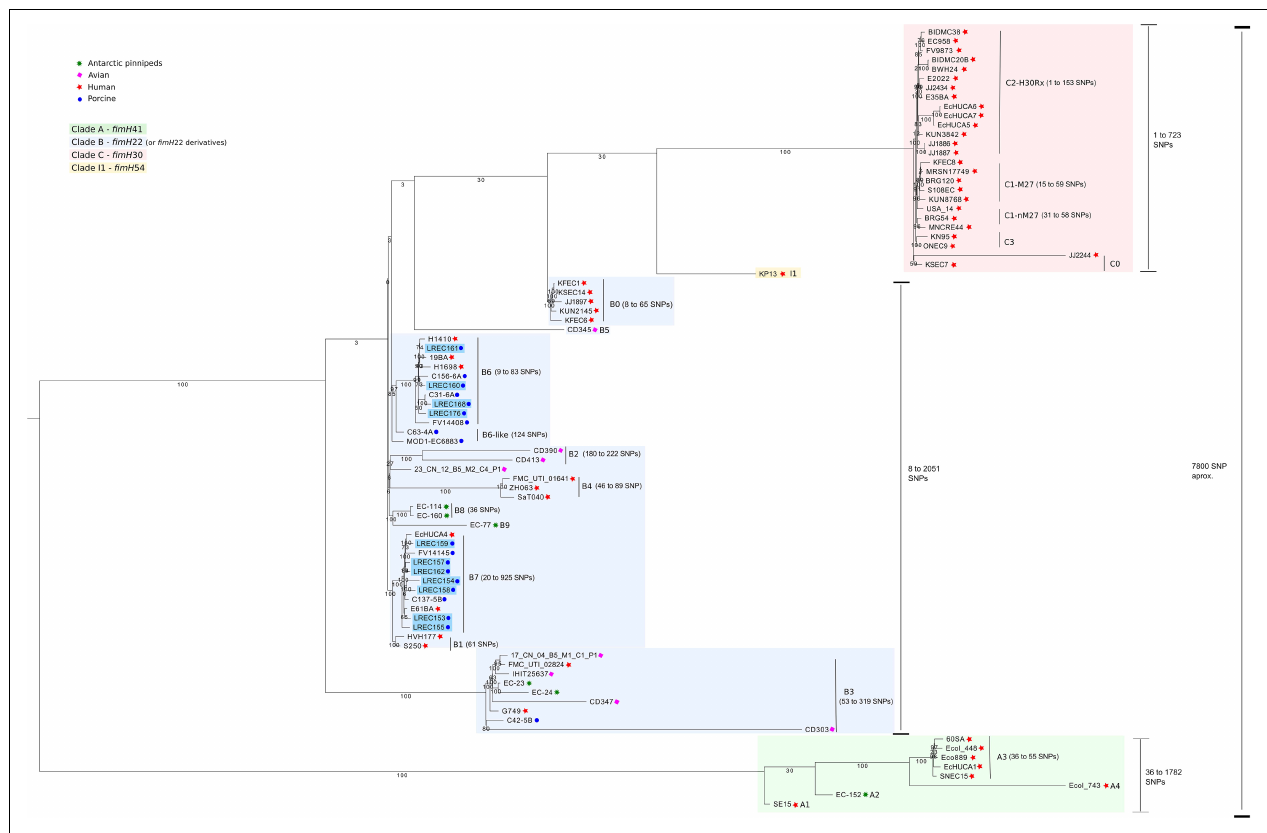
FIGURE 1 | Phylogenetic analysis by core genome of the Escherichia coli sequenced in this study ( n = 11) plus other references ( n = 73) from ST131 clone.